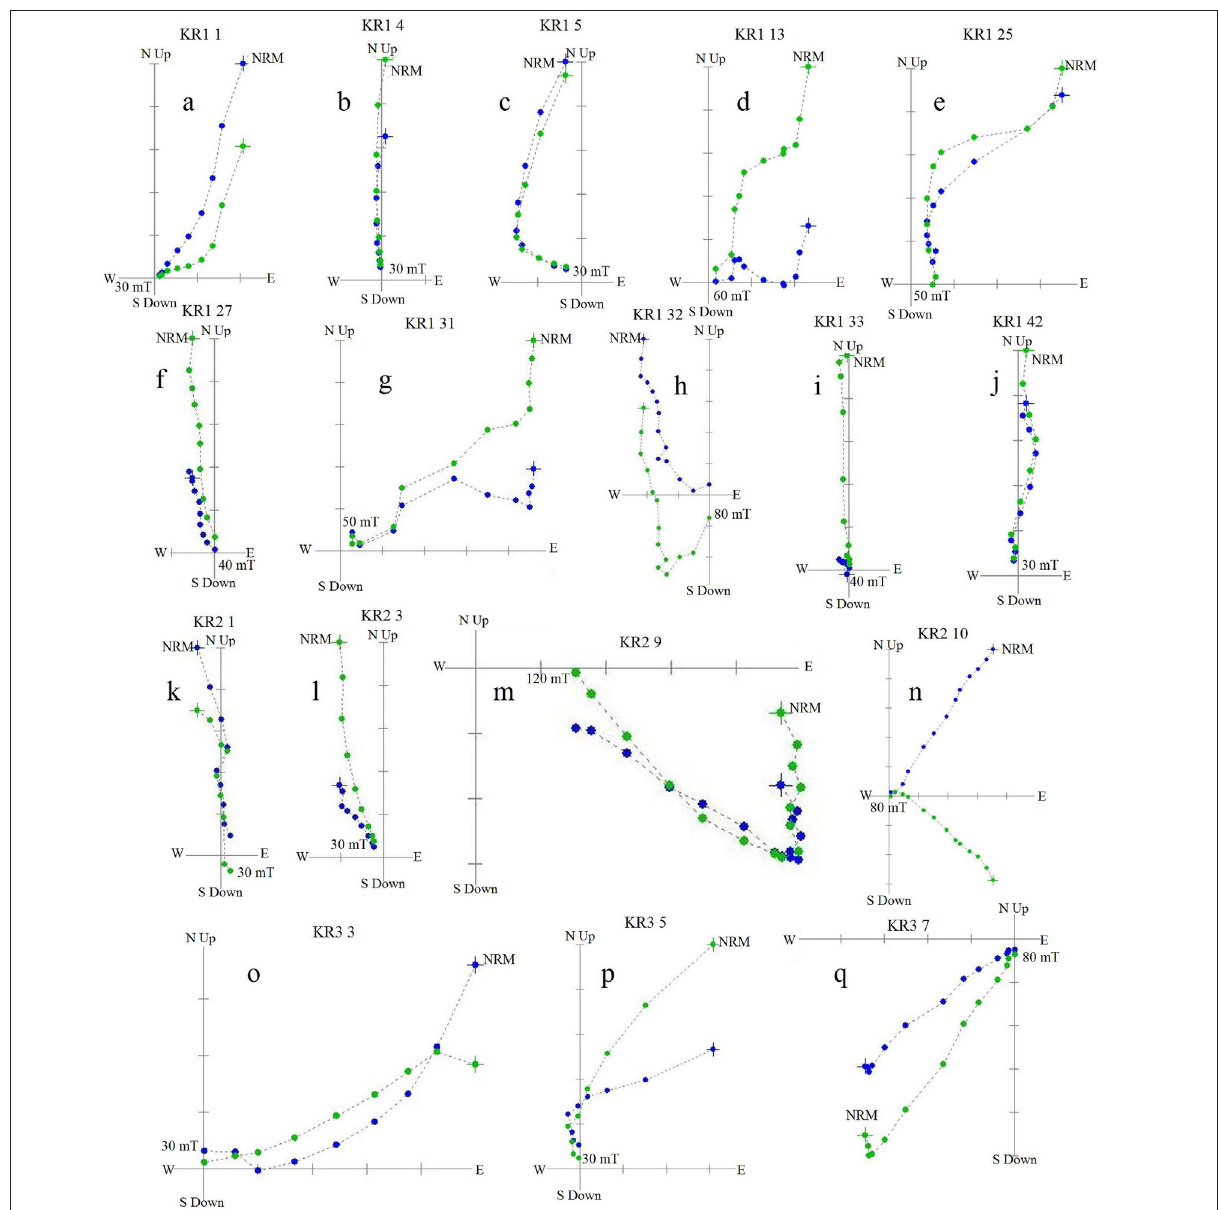
Vector component diagrams of alternating-field demagnetisation behaviour for representative samples from KR Cave 1: (a–j) KR1, (k–n) KR2 and (o–q) KR3. The totality of the vector projection diagrams illustrated in the figures is directional data with corrected field. Blue and green symbols correspond to projection on the horizontal and vertical planes,